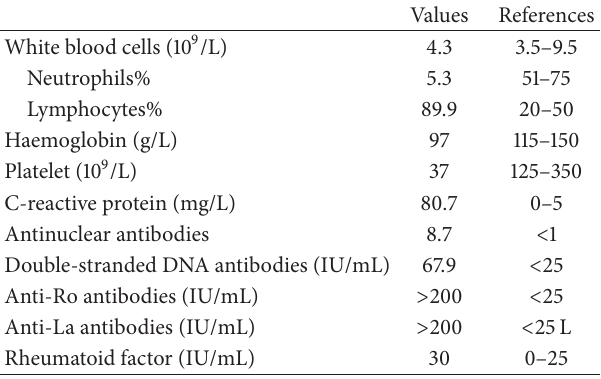
Table 1: Patient’s main laboratory features of peripheral